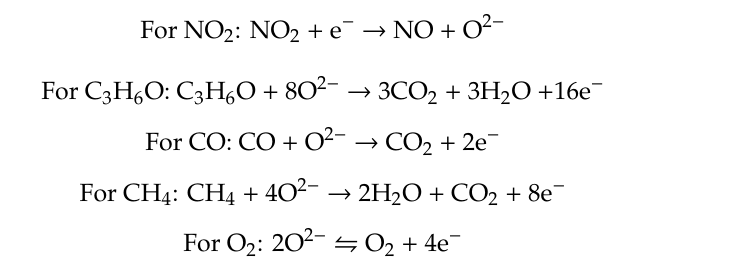
Figure 9. Cross-sensitivity measurement for Sensor C to 100 ppm various gases at 250 °C.